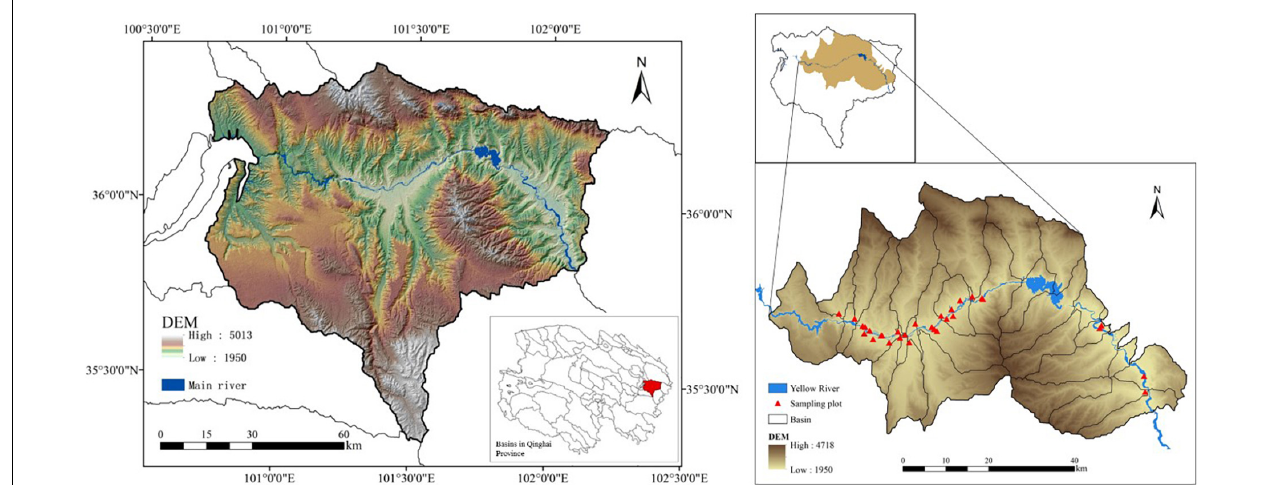
FIGURE 1 | Study area and sampling